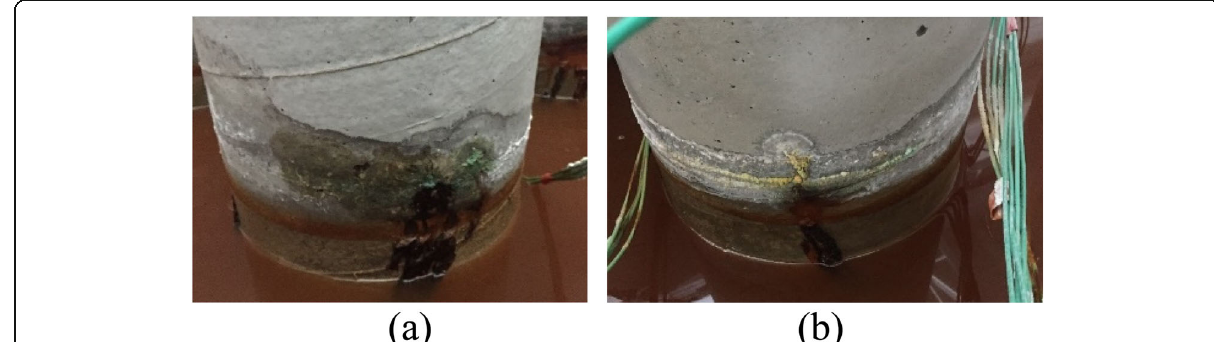
Fig. 4 External signs of corrosion on day 7: a specimen NN-R-2; b specimen